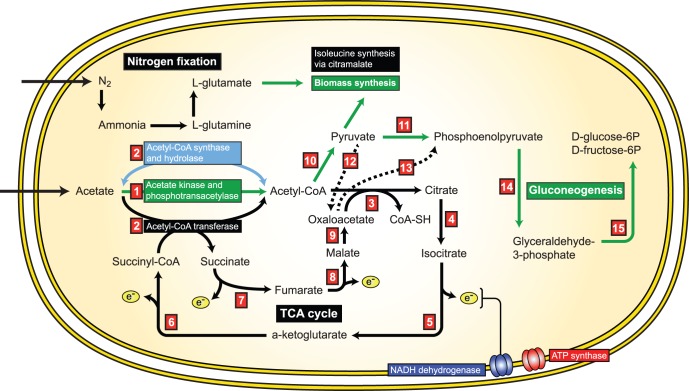
Central metabolism in indigenous Geobacter strains as inferred from proteomic data.Red number-containing boxes refer to specific enzymes in figure 6. Adapted from Mahadevan et al. [30].